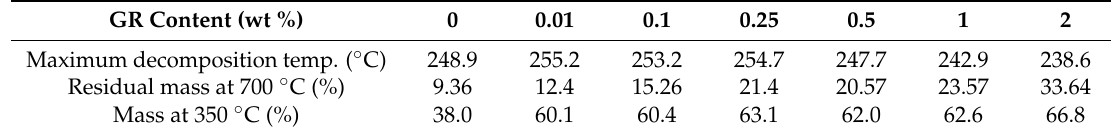
Table 2. TG results of PVA/graphene (GR) nanofiber films.